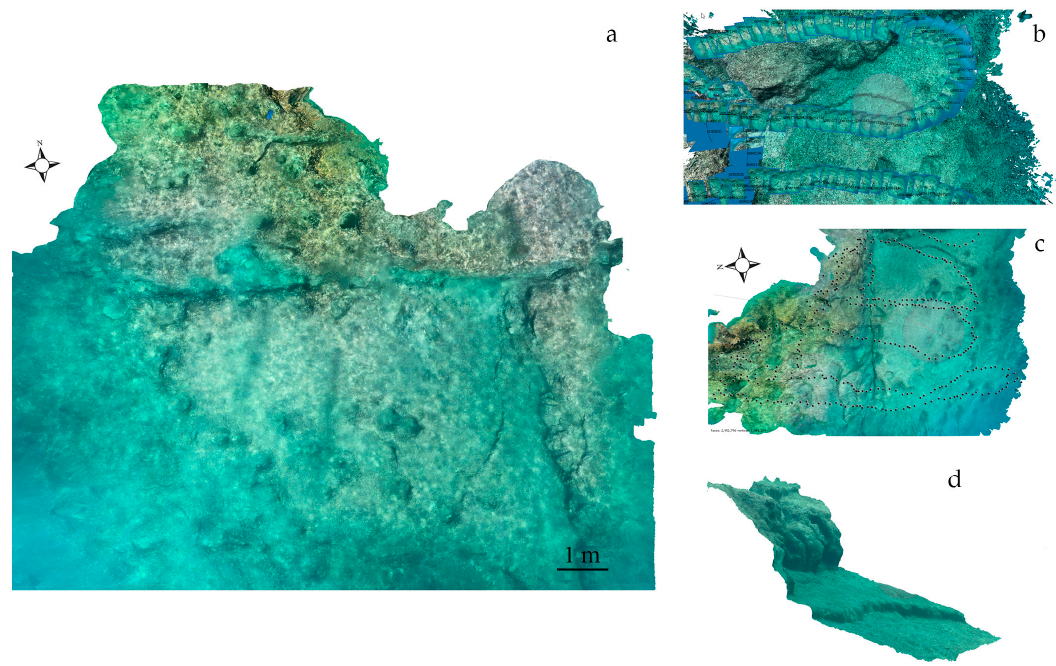
Figure 7. ( a ) A 3D model of the seafloor at the Premantura site, ( b ) the roughly S-shape route followed during the snorkel survey, ( c ) a 3D sketch of a sector of the submerged area, and ( d ) a submerged profile. The submerged landforms on the seafloor are clearly visible in the model, particularly the limestone beds, potholes, and other rounded abrasional landforms.